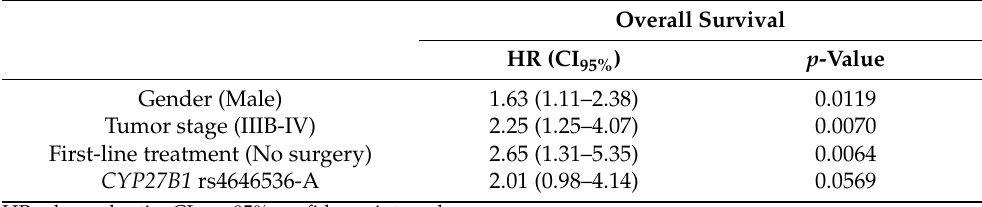
Table 3. Influence of gene polymorphisms and clinical characteristic on overall survival of 194 NSCLC